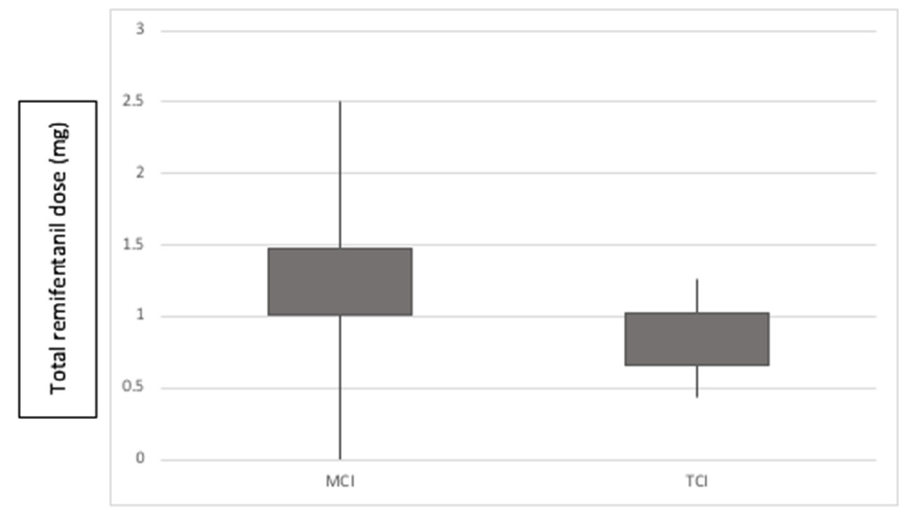
Figure 2. Remifentanil consumption, p = 0.02.